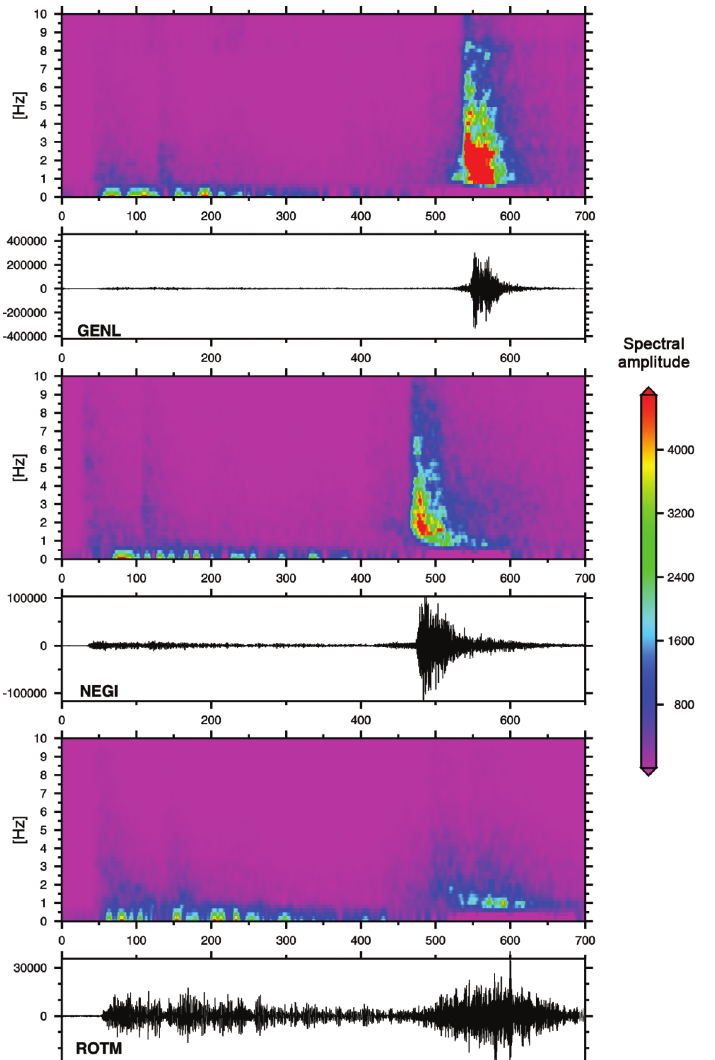
Fig. 8. Sonograms for GENL, NEGI and